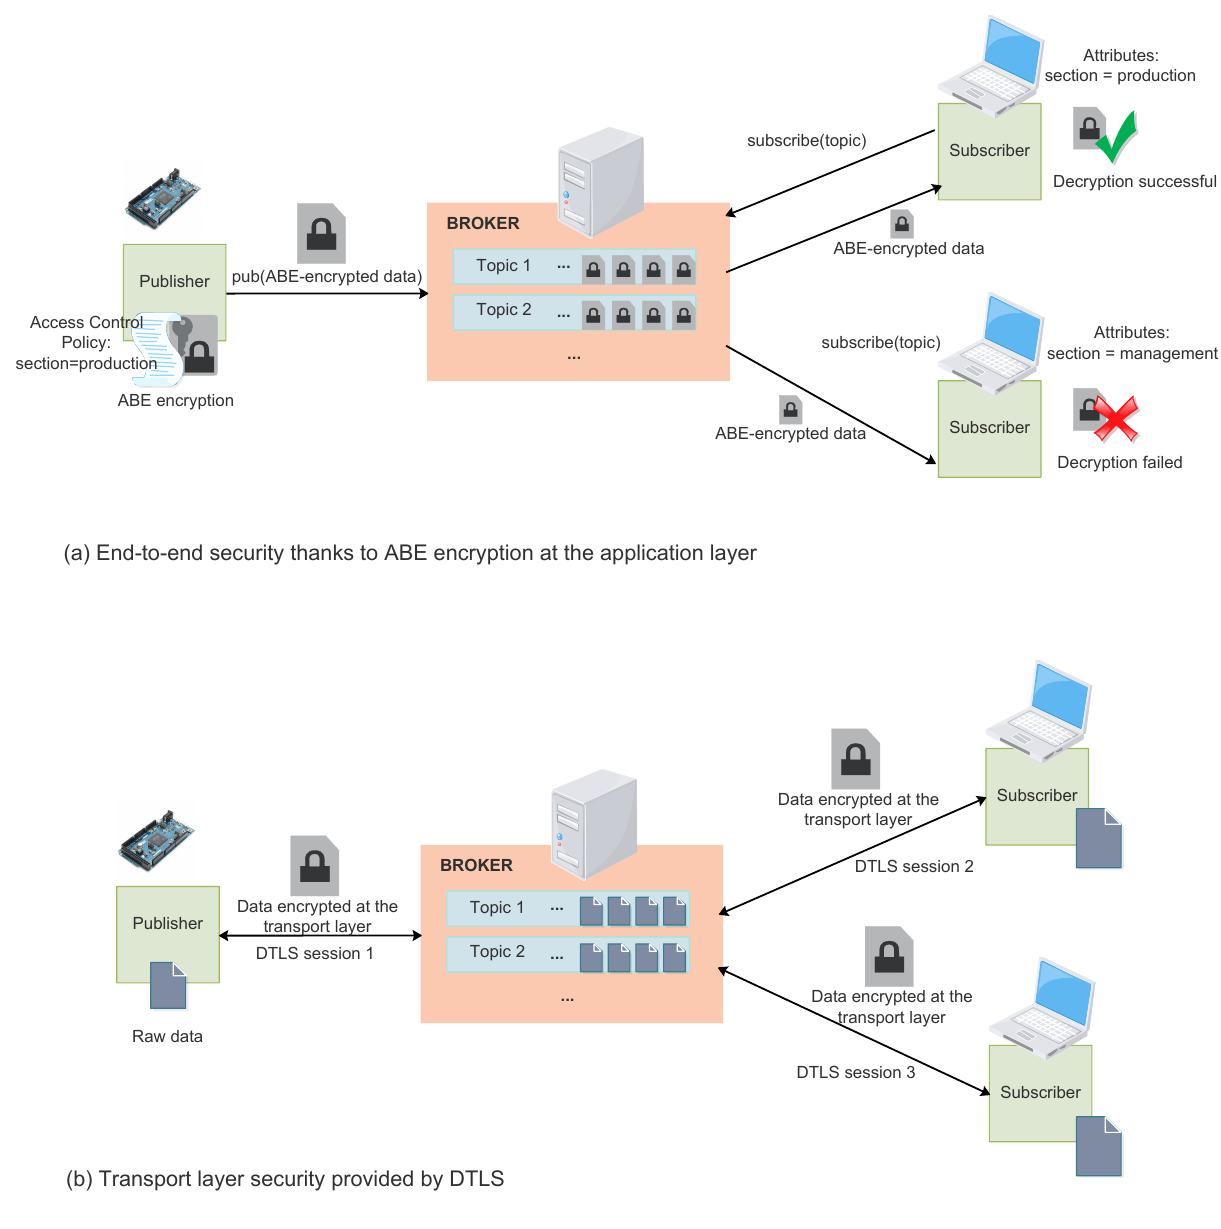
Figure 5. Comparison between: ( a ) end-to-end encryption provided by ABE and ( b ) transport layer encryption provided by DTLS where end-to-end confidentiality is broken at the